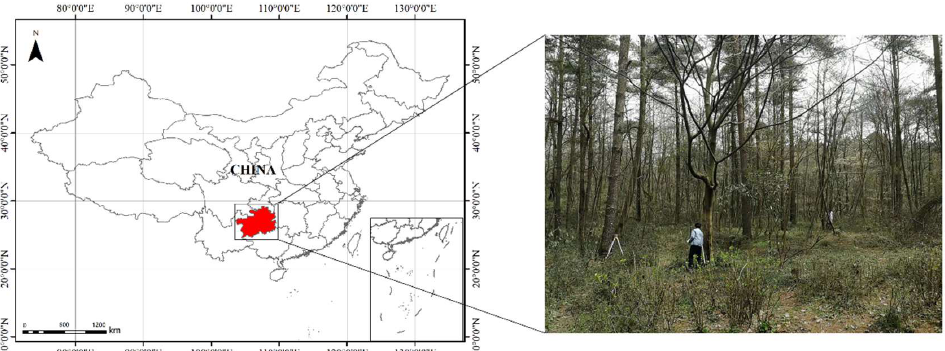
Figure 1. Overview of the forest distribution in the study area.